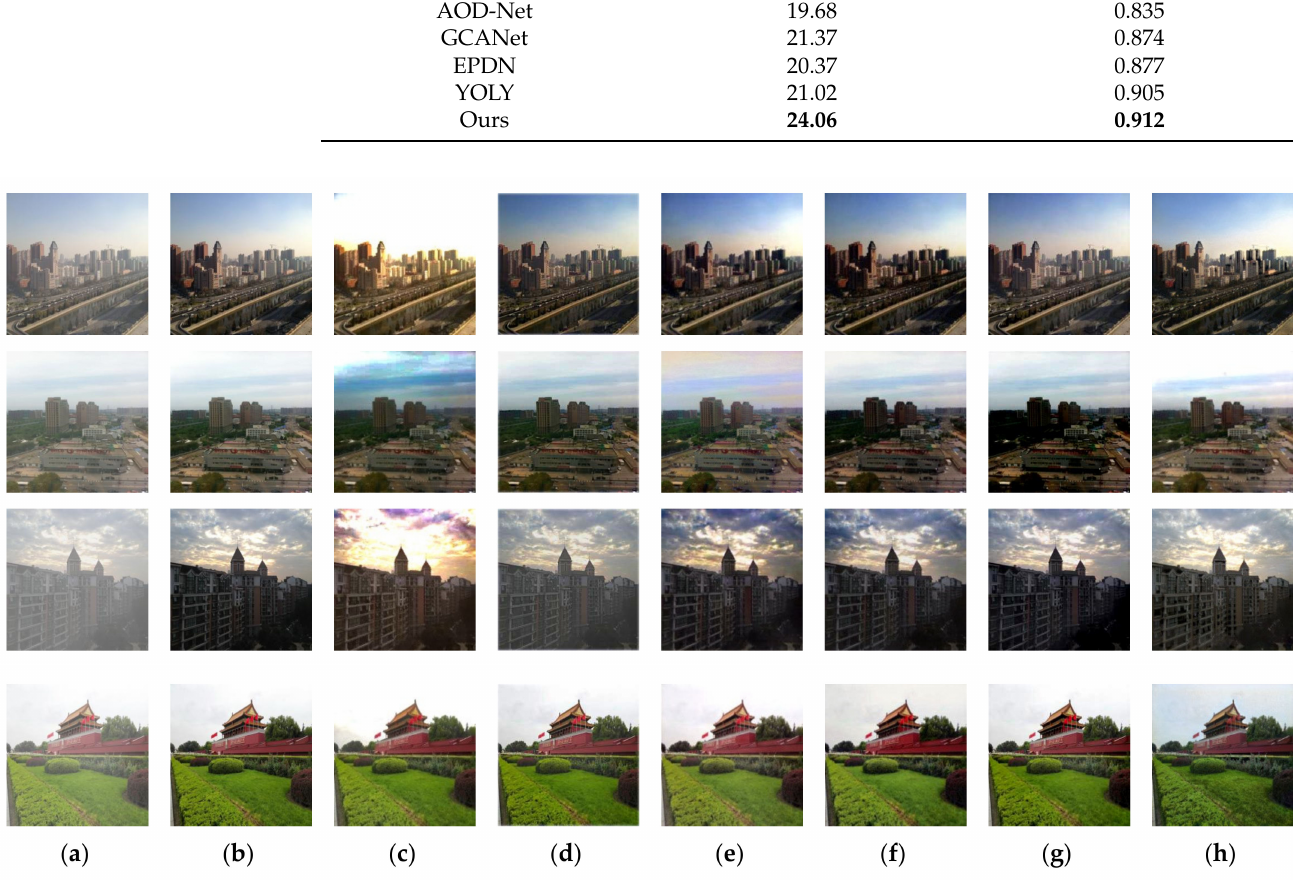
Figure 9. Visual results on the HSTS dataset: ( a ) hazy images; ( b ) corresponding haze-free images; ( c ) DCP; ( d ) AOD-Net; ( e ) GCANet; ( f ) EPDN; ( g ) YOLY; ( h ) proposed